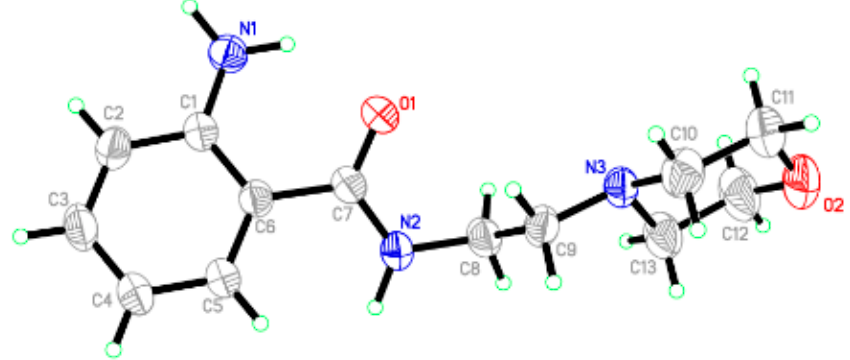
Figure 1. Structure of 3a.